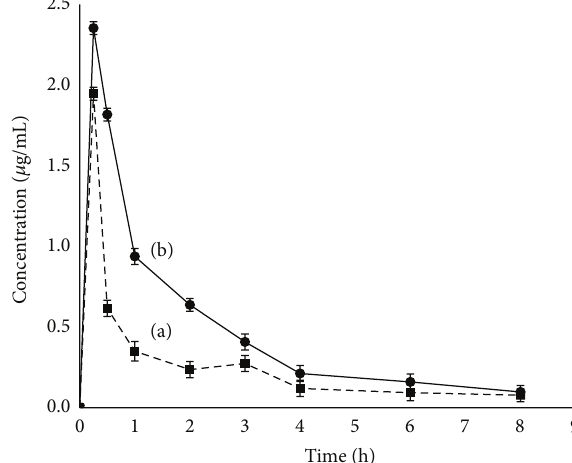
Figure 10: Saturation solubility of r-Res and u-Res in pure water and PBS solution (pH 7.4).